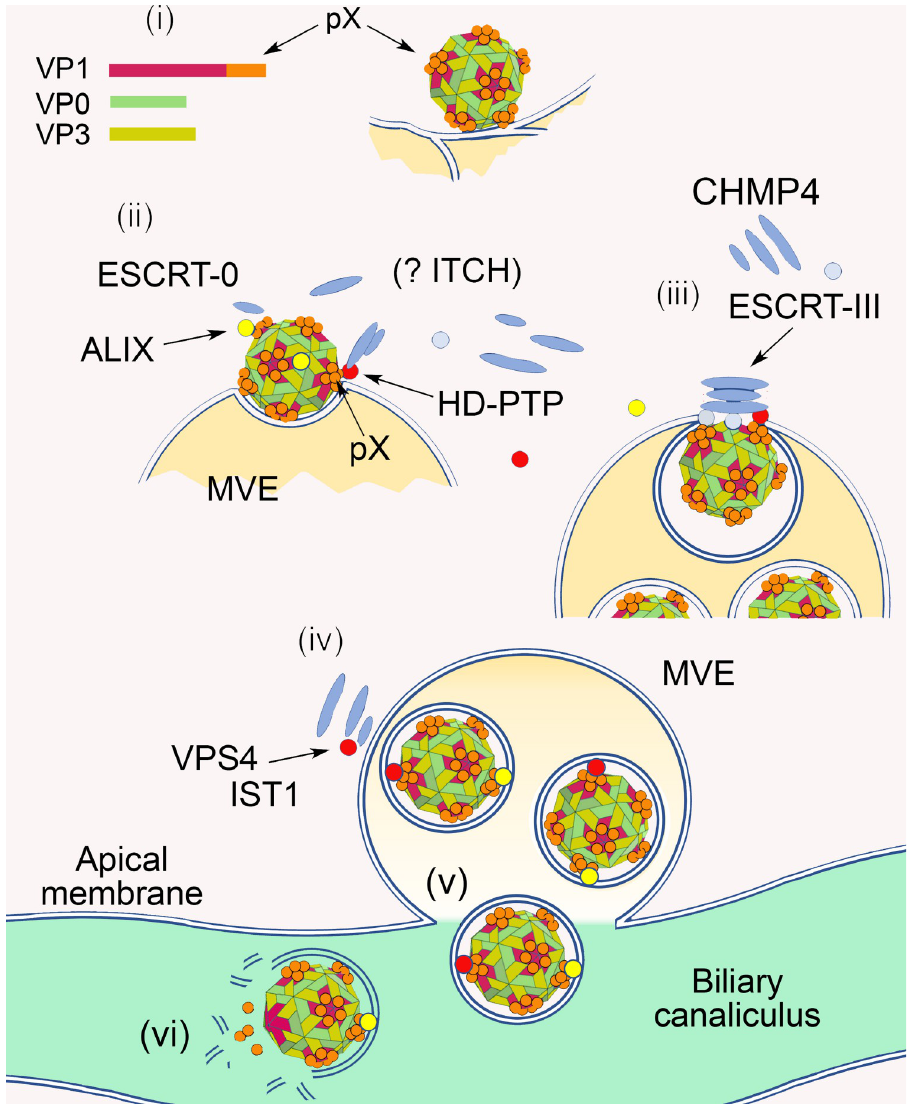
Fig 7. Model scheme showing how Bro1-domain proteins HD-PTP and ALIX could function non-redundantly in nonlytic hepatovirus release from infected hepatocytes. (i) Assembly of membrane-associated capsids decorated on their surface with 60 copies of pX. (ii) pX recruits both ALIX and HD-PTP to capsids. (iii) HD-PTP and ALIX act coordinately to recruit STAM2 (ESCRT-0) and CHMP4, scaffolding assembly of an ESCRT-III complex that facilitates inward budding of the capsid on an endosome and mediates abscission of the membrane leading to formation of a multivesicular endosome (MVE). (iv) Upon membrane abscission, VPS4 mediates disassembly of ESCRT-III, regulated in part by IST1, VTA1 and HD-PTP. (v) MVEs traffic to the apical plasma membrane of the hepatocyte where membrane fusion releases quasi-enveloped eHAV into the biliary canaliculus. (vi) Bile salts degrade the eHAV membrane resulting in naked nHAV particles being released from the biliary tract into the small intestine [10].